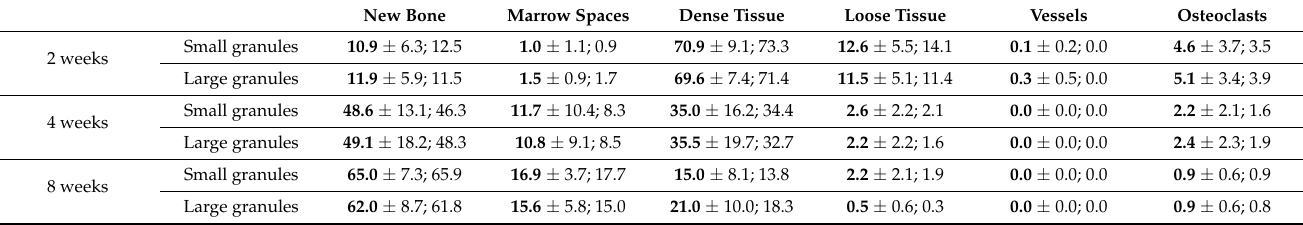
Table 3. BGC in the various regions evaluated within the augmented sinus in the three periods of evaluation. Mean values (in bold) ± standard deviations; median in percentages.